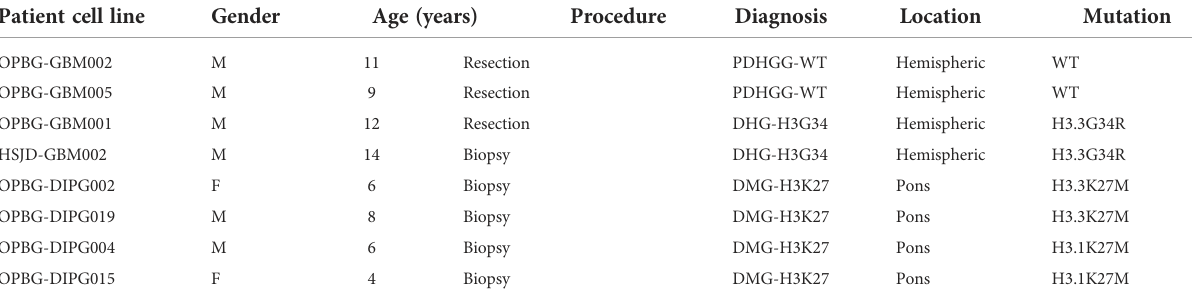
TABLE 3 Summary of the clinico-pathological data for the eight PDHGG primary patient-derived cell lines used for the study. Patient cell